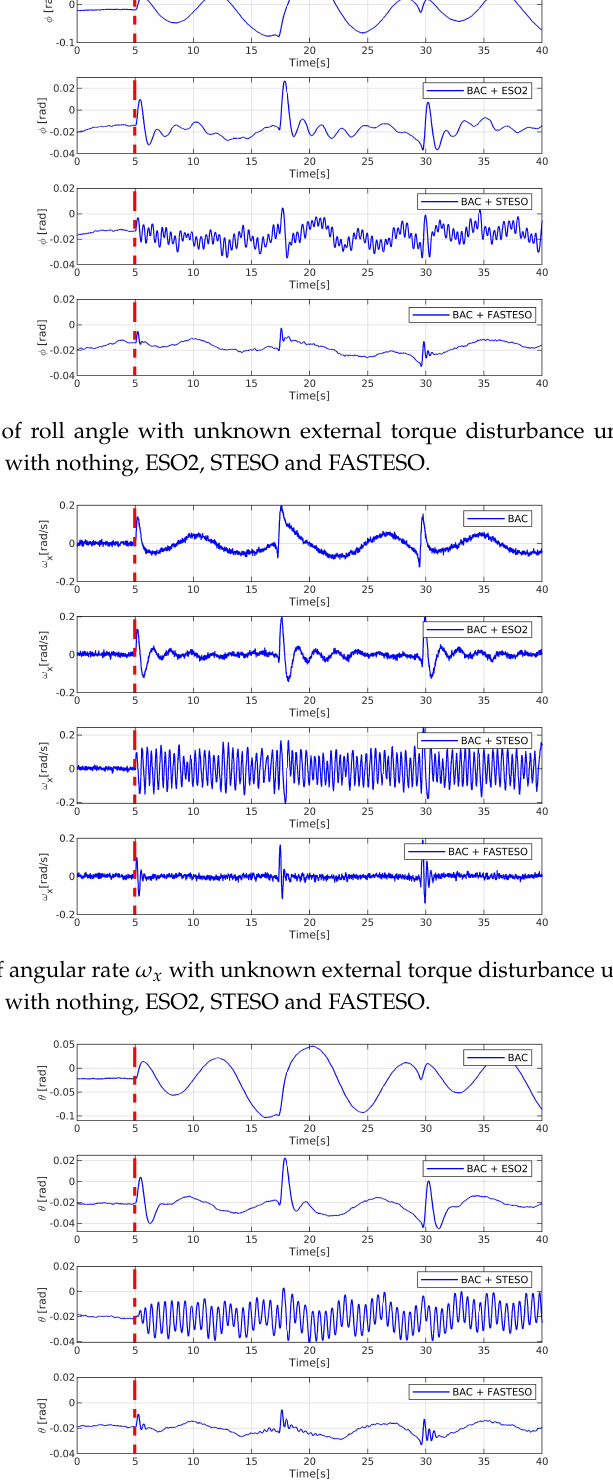
Figure 13. Results of pitch angle with unknown external torque disturbance under backstepping controller combined with nothing, ESO2, STESO and